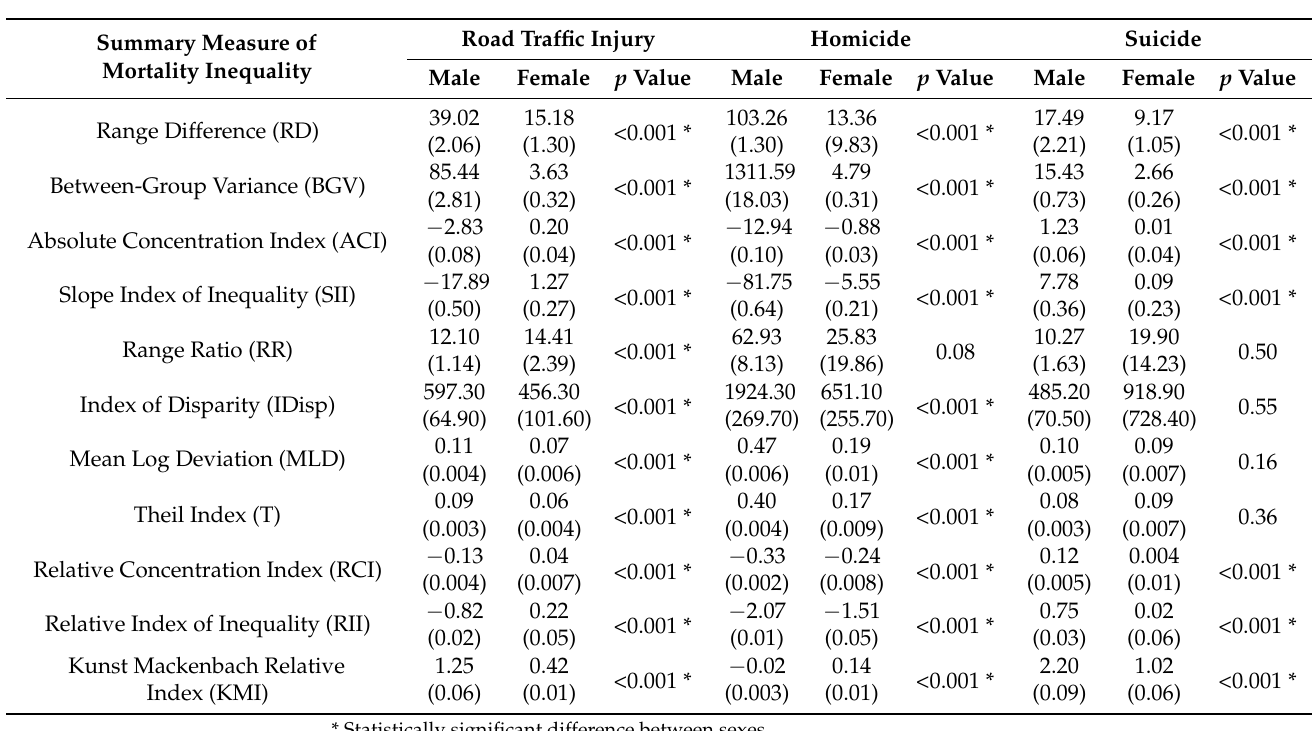
Table 2. Magnitude of mortality inequality, its standard error, and p -value, by type of inequality measurement, sex, and cause of violent death in young (10–24 years old) people. Region of the Americas, 2015.